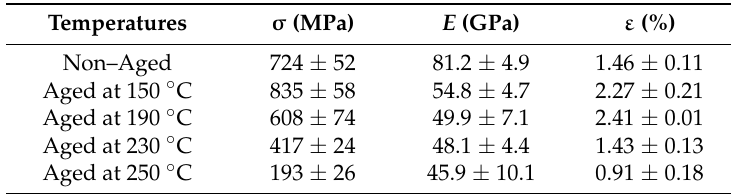
Table 7. Average values of maximum flexural stress, flexural modulus of elasticity and maximum flexural strain of quasi-isotropic laminates aged at different temperatures for 10 days. Standard deviation is included.